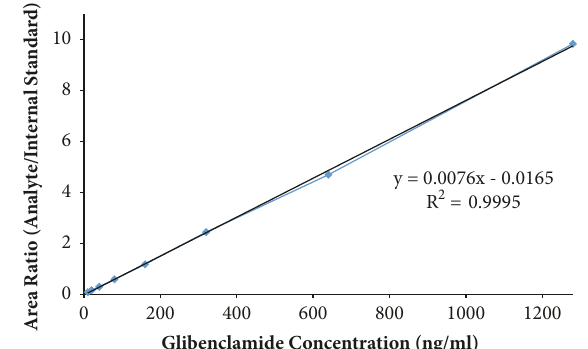
as plasma samples. The extent of recovery of glibenclamide and of the glimepiride was consistent and